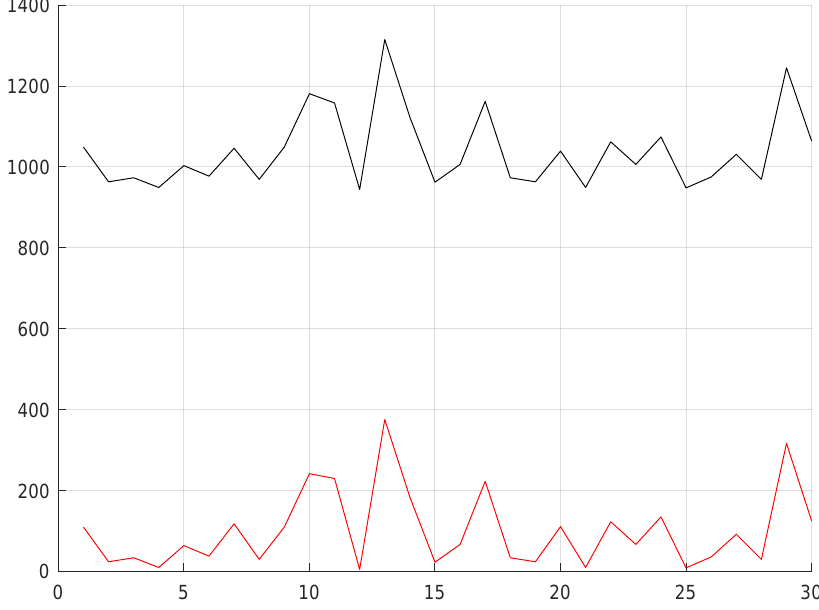
Figure 17. The black curve is the time that the platform takes to complete all sampling, and the red curve represents the time it takes to find the